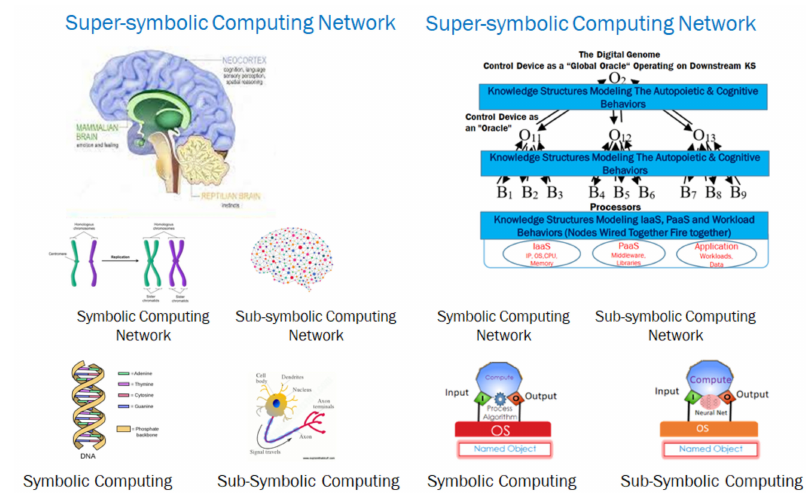
Figure 1. Super-symbolic computing in biological and digital